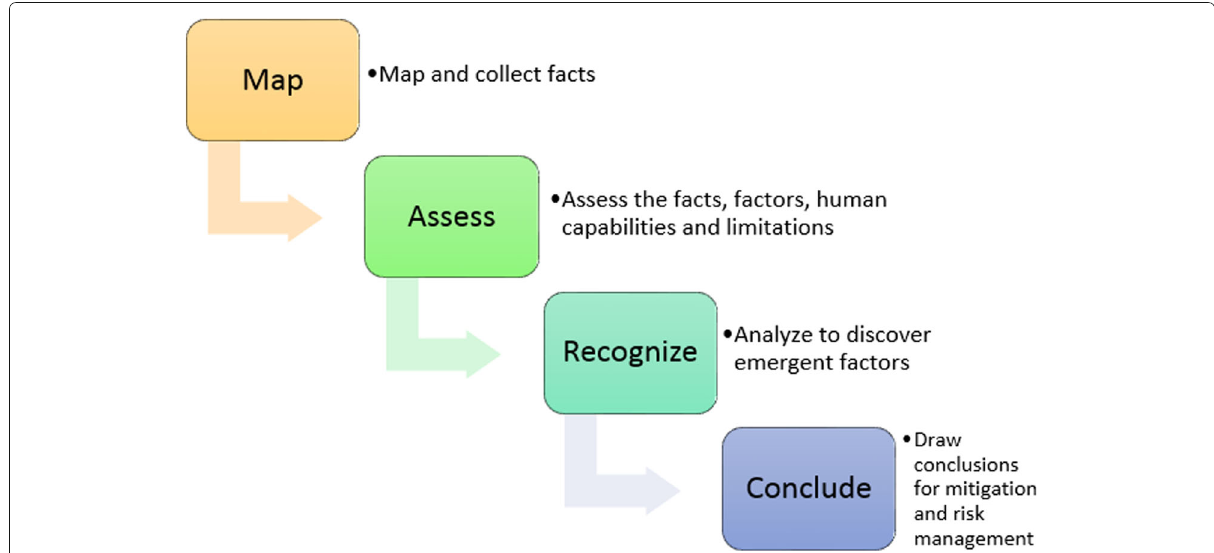
Fig. 6 Interpretation of MARC process, based on Parush et al. (2017)